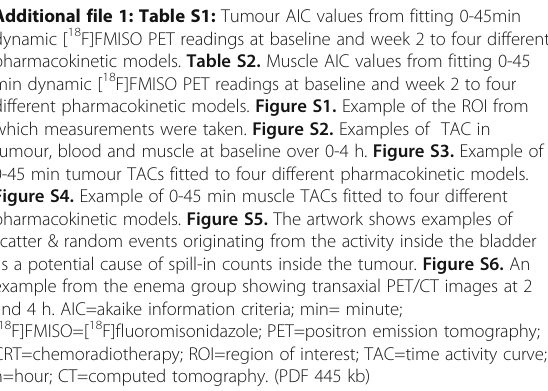
Figure S1. Example of the ROI from which measurements were taken. Figure S2. Examples of TAC in tumour, blood and muscle at baseline over 0-4 h. Figure S3. Example of 0-45 min tumour TACs fitted to four different pharmacokinetic models. Figure S4. Example of 0-45 min muscle TACs fitted to four different pharmacokinetic models. Figure S5. The artwork shows examples of scatter & random events originating from the activity inside the bladder as a potential cause of spill-in counts inside the tumour. Figure S6. An example from the enema group showing transaxial PET/CT images at 2 and 4 h. AIC=akaike information criteria; min= minute; [ 18 F]FMISO=[ 18 F]fluoromisonidazole; PET=positron emission tomography; CRT=chemoradiotherapy; ROI=region of interest; TAC=time activity curve; h=hour; CT=computed tomography. (PDF 445